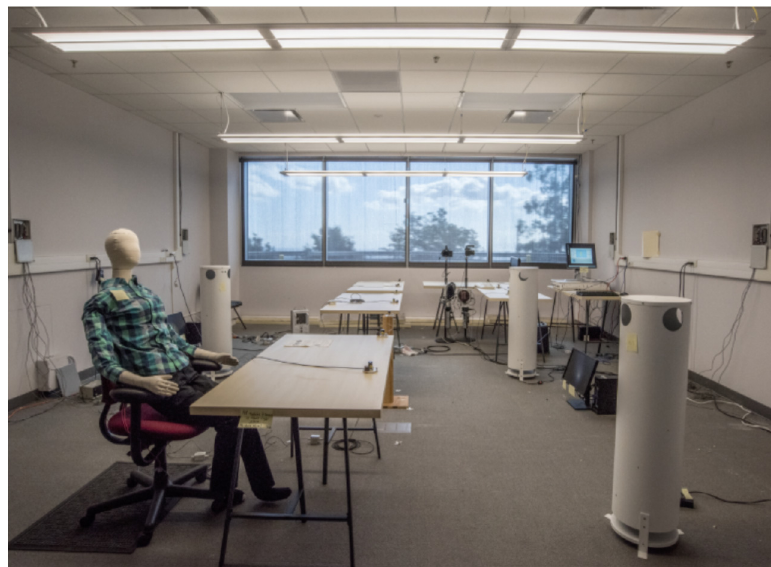
Figure 2. Photograph of Test System 1 setup in the lab, with automated roller shades along the window wall, and daylight-responsive suspended LED fixtures overhead. Thermal loads are emulated with the mannequin and the vertical cylinders shown. Illuminance sensors are shown on the desk surfaces and the digital cameras capturing HDR imagery are visible near the window wall.